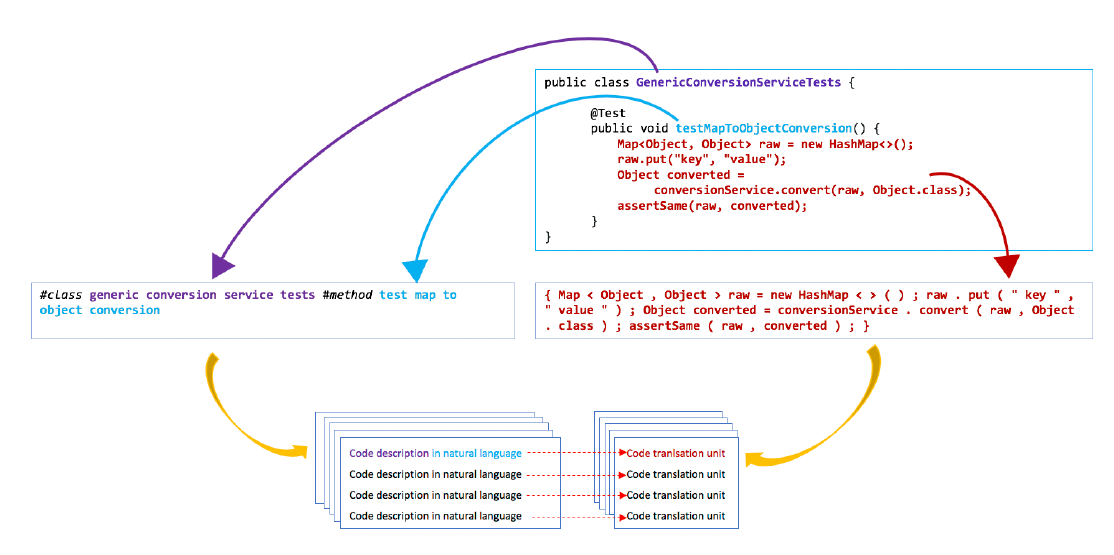
Figure 3. Extracting a text-code sequence pair from a test